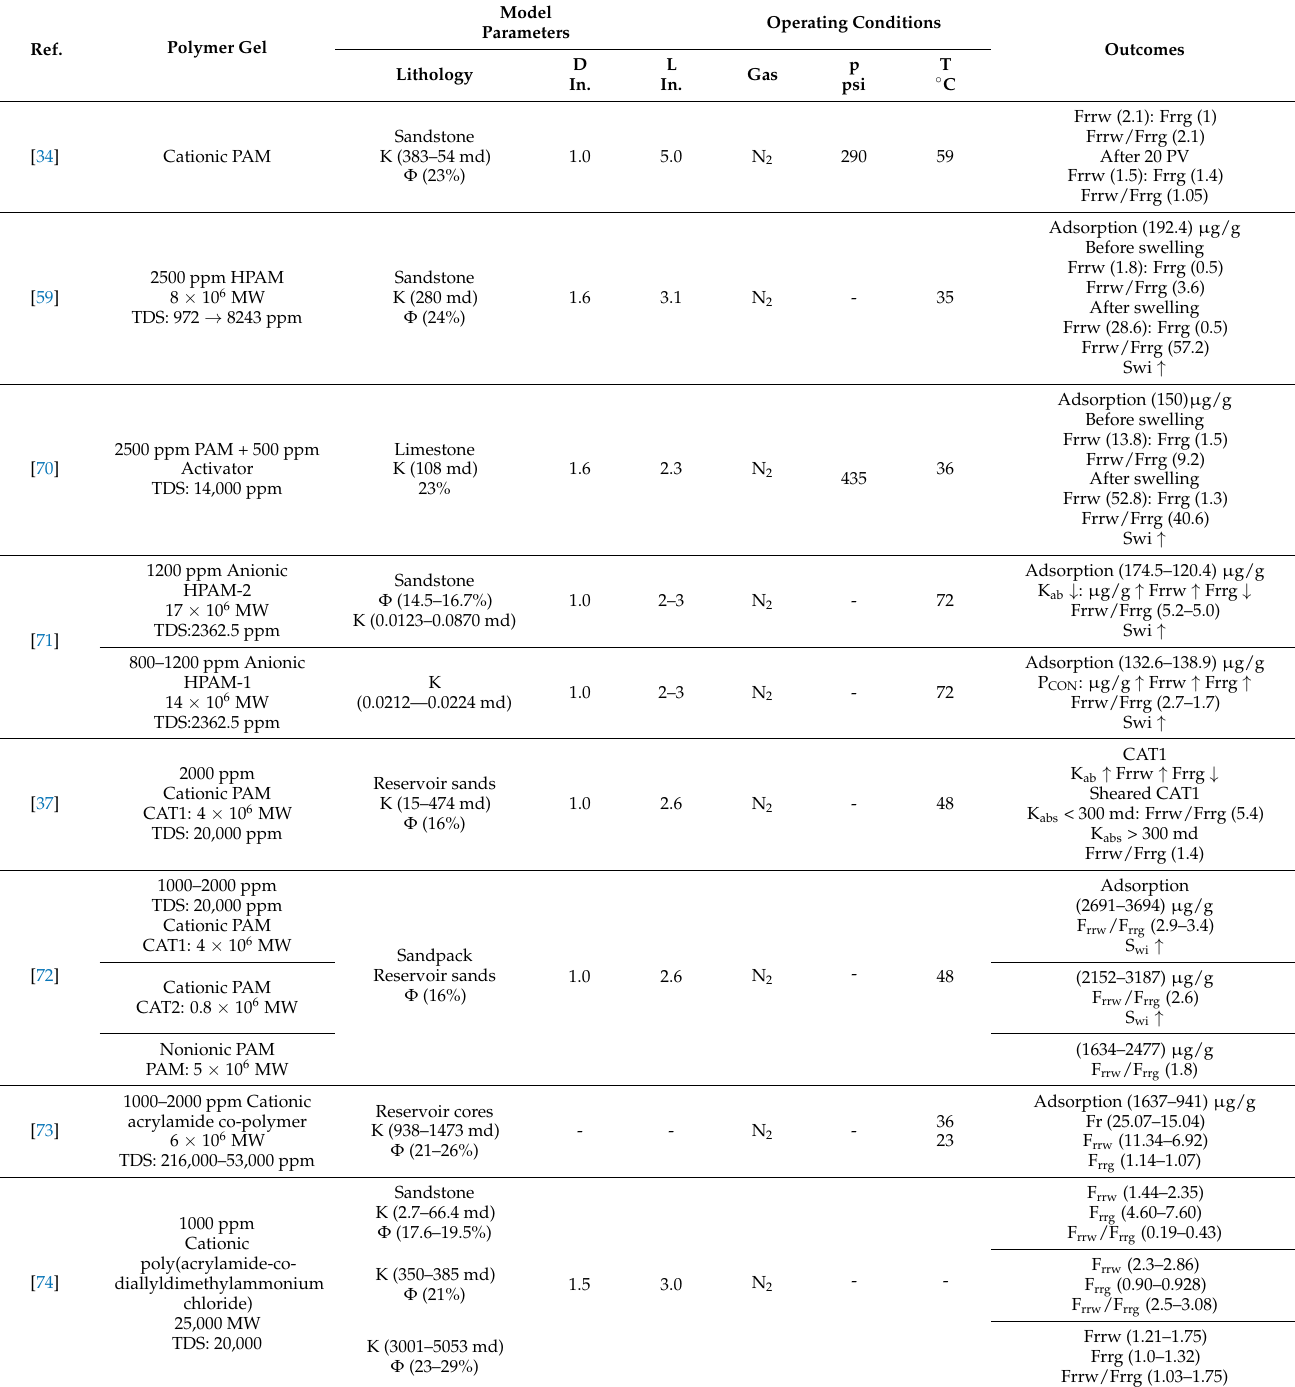
Table 10. Polymer systems—lab